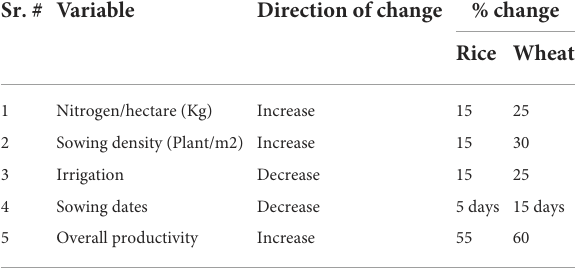
Percentage change (% change) shows the percentage of farmers using the crop management practices related to crop models to reduce the adverse effects of